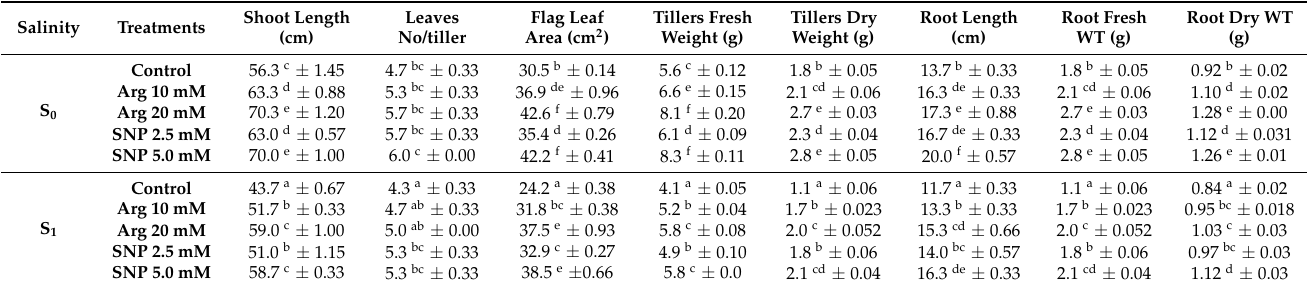
Table 1. Effect of arginine or SNP on growth indices of wheat plants under salinity stress. S 0 = 1.2 mM NaCl, S 1 = 85.5 mM